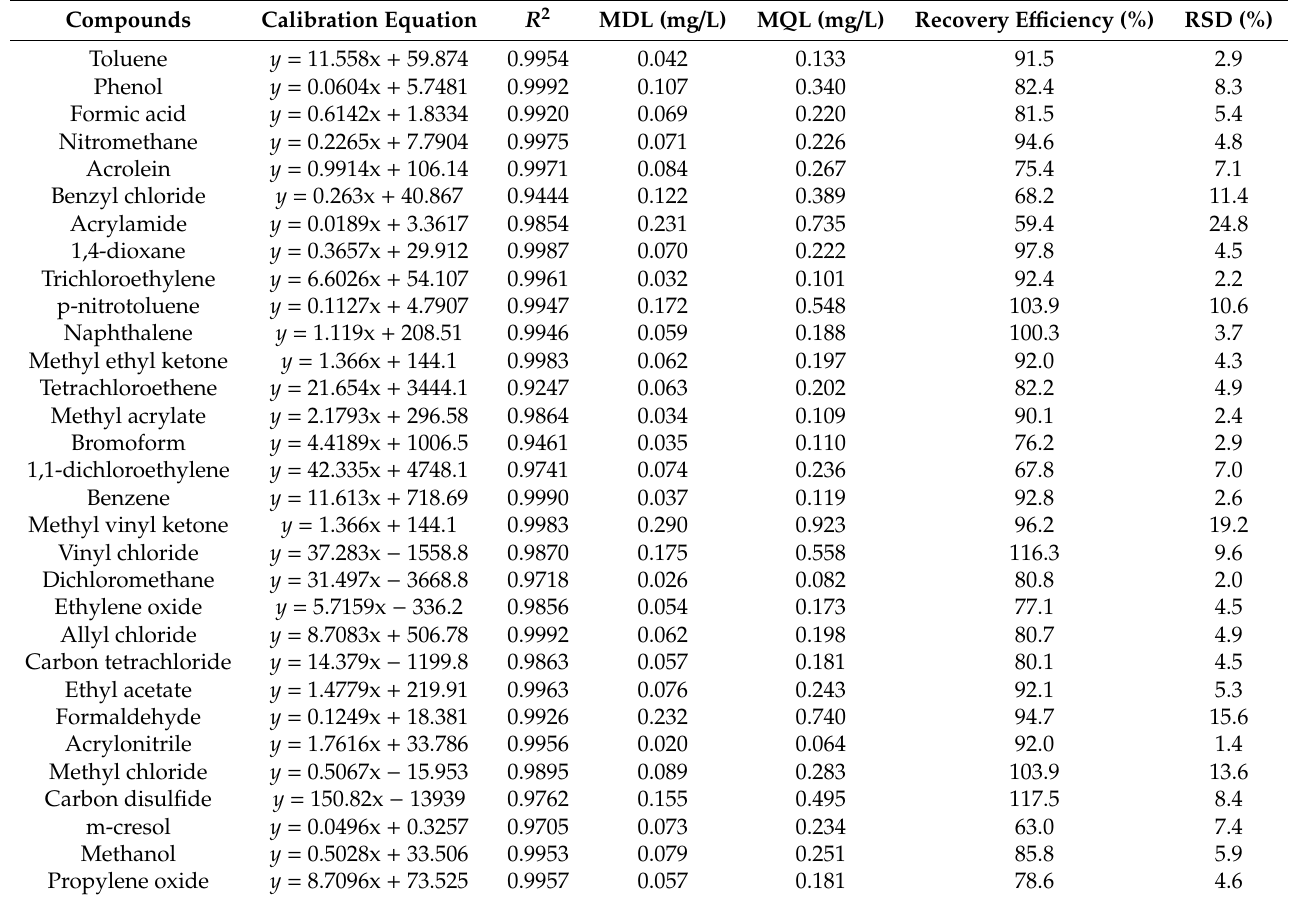
Table 2. Calibration linearity, method detection limit (MDL), method quantification limit (MQL), recovery, and relative standard deviation (RSD) of headspace–selected ion flow tube mass spectrometry